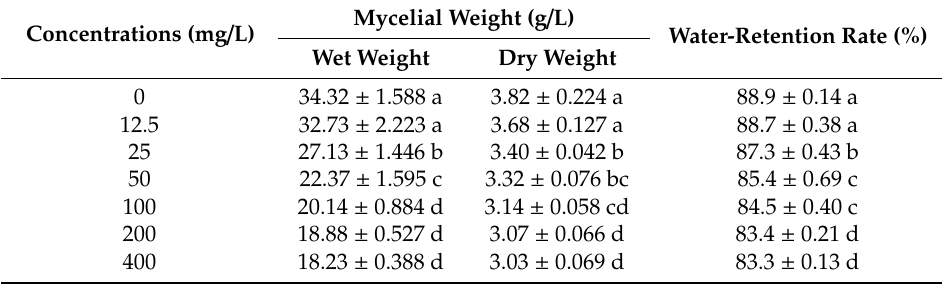
Table 1. The mycelial weights and water-retention of P. digitatum treated with different concentrations of PiCB.